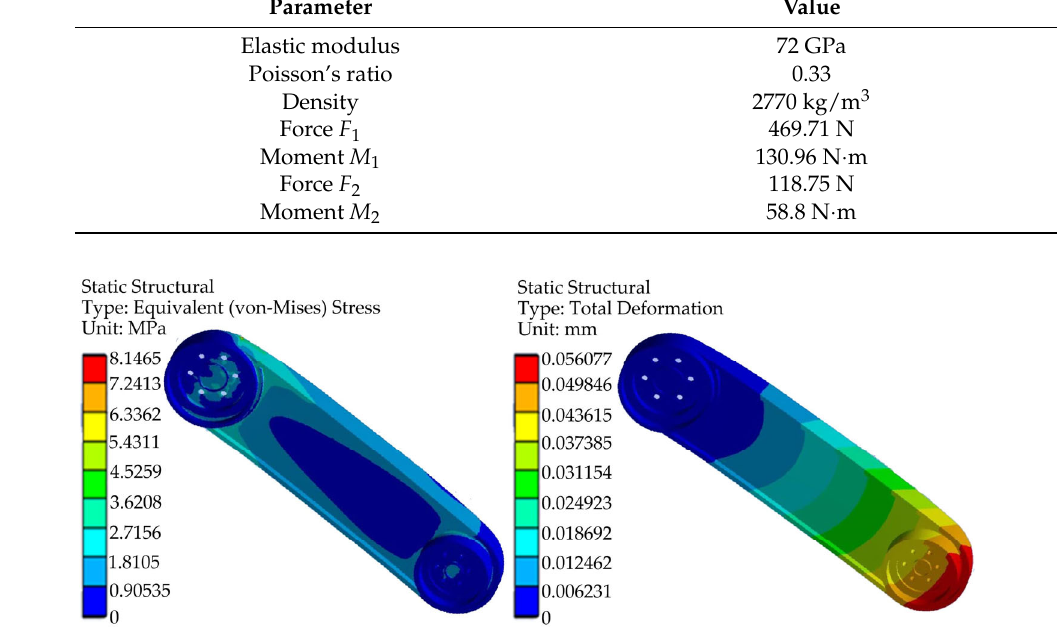
Figure 9. Stress and deformation distribution for the big arm.